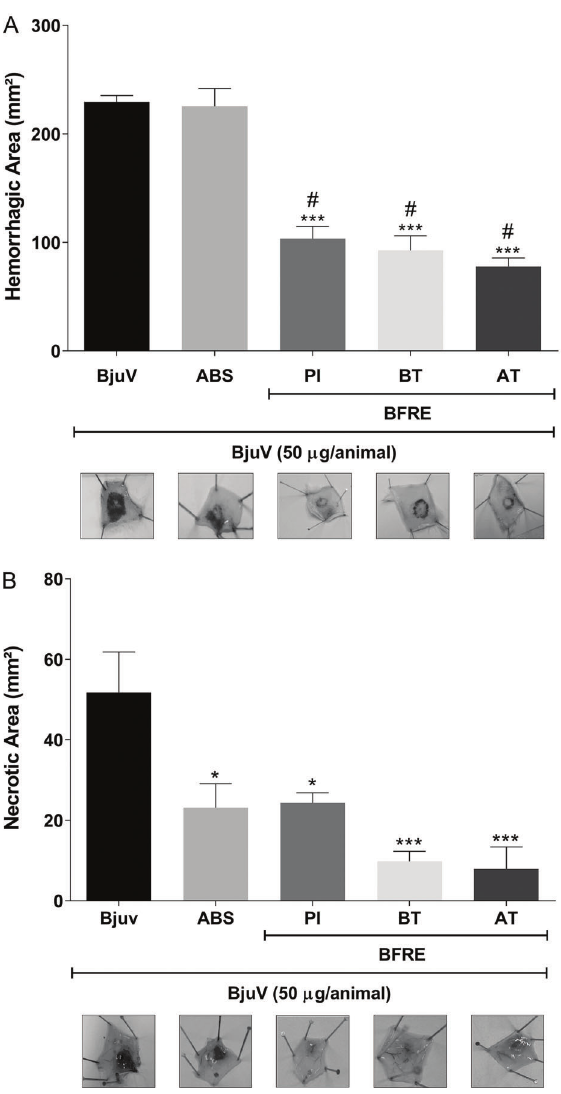
Figure 5. Effect of Bredemeyera fl oribunda root extract (BFRE) on hemorrhagic ( A ) and necrotizing ( B ) effects of Bothrops jararacussu venom (BjuV). Lesion areas were calculated in mm 2 . Data are reported as means ± SE. *P o 0.05, ***P o 0.001 compared to BjuV; # P o 0.05 compared to ABS (ANOVA with Bonferroni post-test). BT: group treated with BFRE (150 mg/kg, ip ) 30 min before BjuV inoculation; AT: group treated with BFRE (150 mg/kg, ip ) 30 min after BjuV inoculation; PI: BjuV and BFRE (1:3) preincubated for 15 min at 37°C before inoculation; ABS: antibothropic serum. are well-known inhibitors of snake venom PLA2 enzymatic and toxic activities